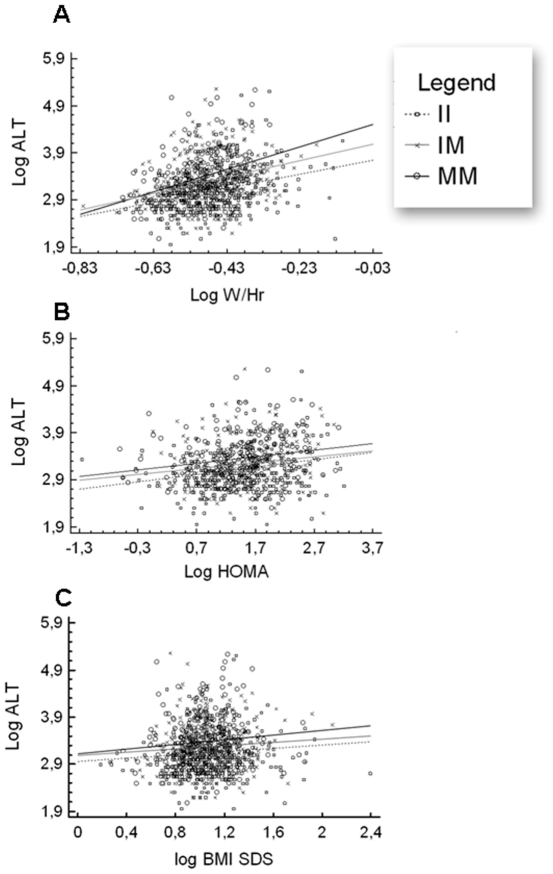
Association between ALT levels and W/Hr, HOMA and BMI-SDS according to the PNPLA3 genotype.
A: Regression analysis describing the relationship between ALT levels and W/Hr in patients homozygous for PNPLA3 M variant, heterozygous, and homozygous for PNPLA3 I variant. The regression between ALT levels and W/Hr in the group of patients homozygous for PNPLA3 M/M is described by the equation y = 4.6+2.4*× (r = 0.36; p = 0.00001). The equation for PNPLA3 I/M was y = 3.7+1.4*× (r = 0.22; p = 0.00001). The equation for PNPLA3 I/I was y = 3.4+1.1*× (r = 0.17; p = 0.0005). The comparison between the three regression lines is significant (p = 0.0045). B: Regression analysis describing the relationship between ALT levels and HOMA-IR in patients homozygous for PNPLA3 M variant, heterozygous, and homozygous for PNPLA3 I variant. The regression between ALT levels and HOMA-IR in the group of patients homozygous for PNPLA3 M/M is described by the equation y = 3.2+0.14*× (r = 0.18; p = 0.02). The equation for PNPLA3 I/M was y = 3.0+1.12*× (r = 0.16; p = 0.001). The equation for PNPLA3 I/I was y = 2.9+0.16*× (r = 0.23; p = 0.00005). The three equations are not significantly different as to slopes (p = 0.7). C: Regression analysis describing the relationship between ALT levels and BMI z-score in patients homozygous for PNPLA3 M variant, heterozygous, and homozygous for PNPLA3 I variant. The regression between ALT levels and BMI z-score in the group of patients homozygous for PNPLA3 M/M is described by the equation y = 3.1+0.24*× (r = 0.01; p = 0.13). The equation for PNPLA3 I/M was y = 3.1+0.17*× (r = 0.08; p = 0.14). The equation for PNPLA3 I/I was y = 2.9+0.17*× (r = 0.09; p = 0.04). The three equations are not significantly different as to slopes (p = 0.5).